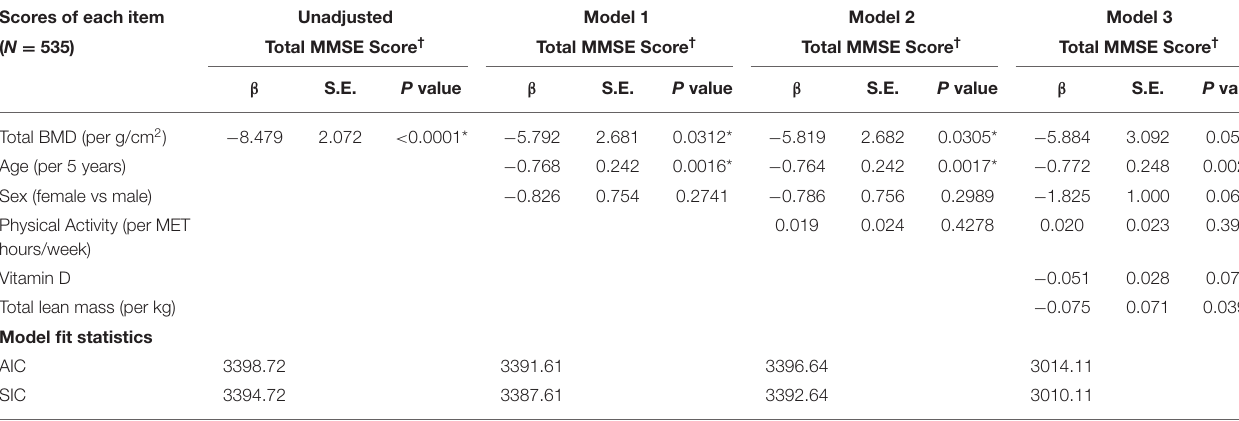
TABLE 5 | Generalized linear mixed model estimates of the Mini-Mental State Examination (MMSE). Scores of each